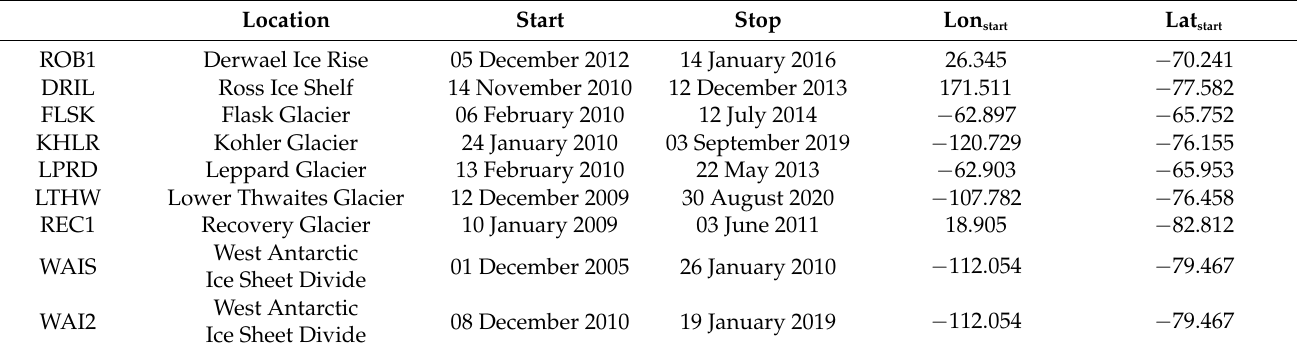
Table 1. Summary of the different antenna dataset time spans used in this analysis and longitude and latitude at the beginning of the